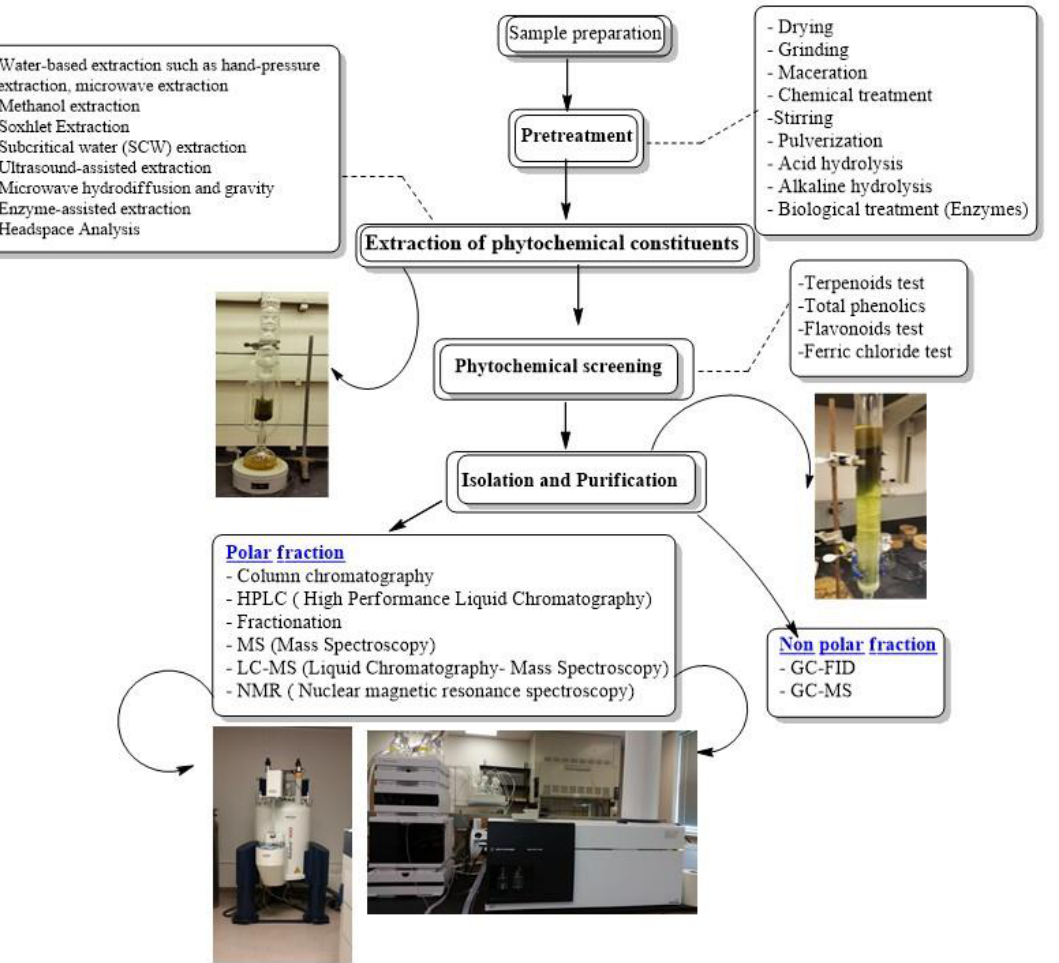
Figure 2. Flowchart of stages involved in extraction, isolation and characterization of bioactive compounds from Artemisia.